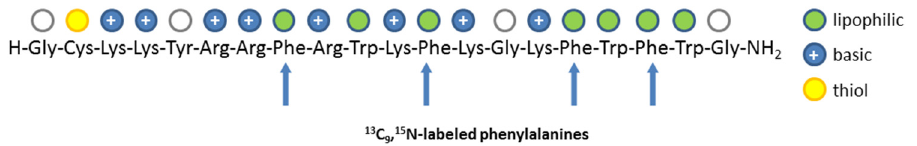
Figure 3. Sequence of Pep19 ‐ 2.5. The arrows indicate the positions of the 13 C 9 , 15 N 1 ‐ labeled phenyl ‐ alanine residues incorporated in the solid phase peptide